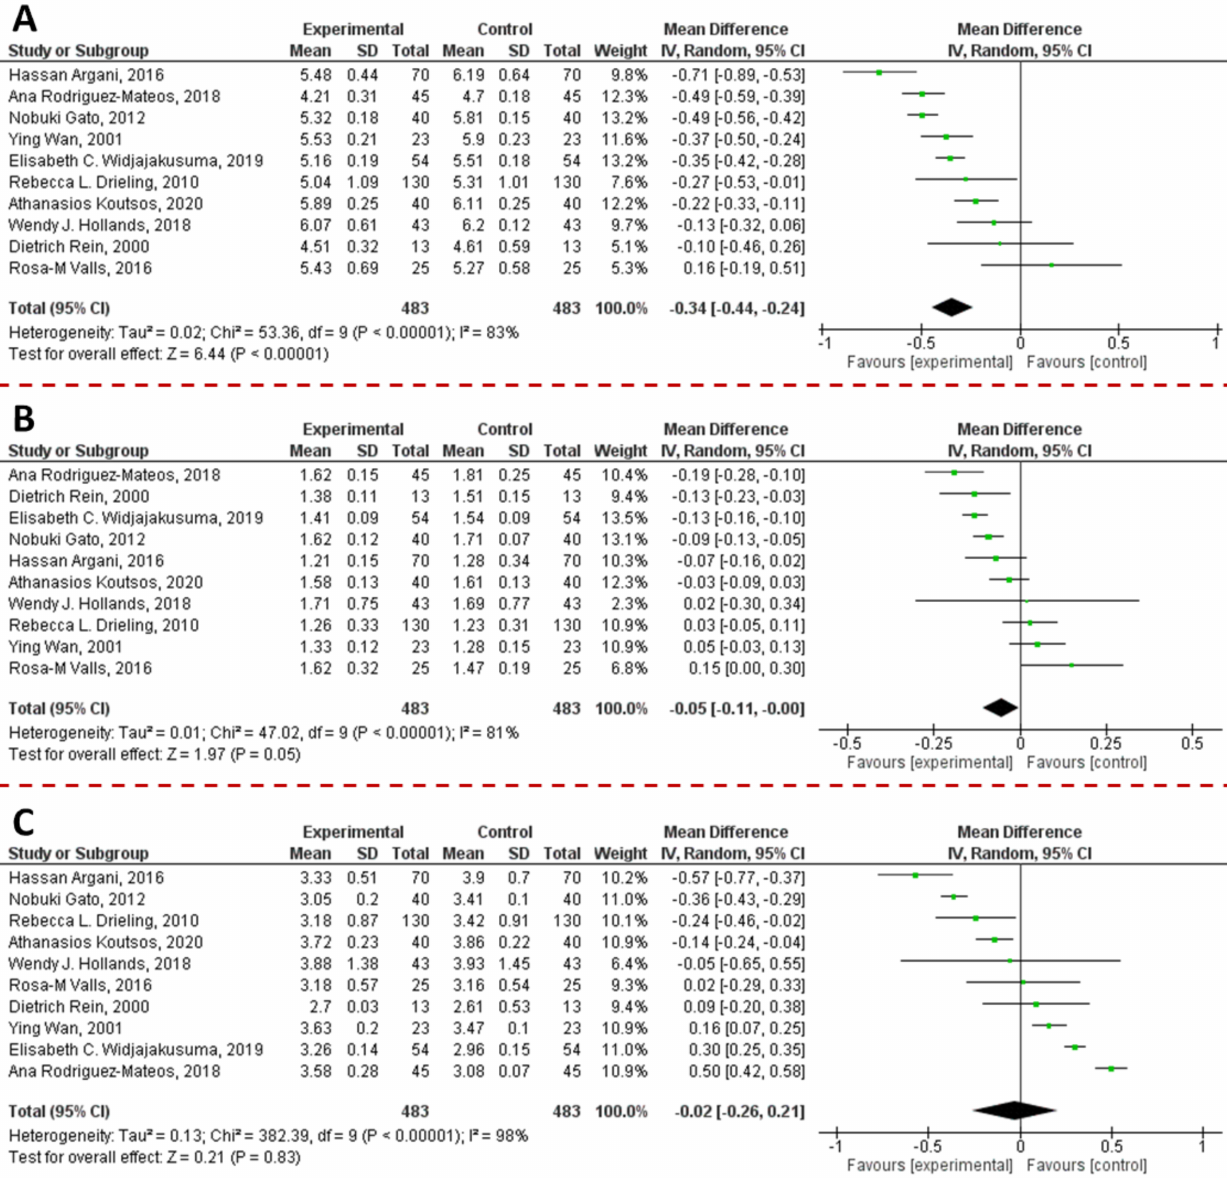
Figure 16. Forest plot representation of the effects derived from the supplementation of PACs on total cholesterol ( A ), HDL ( B ), and LDL ( C ) levels. Data were extrapolated from [187,267–275], and plotted according to the mean difference. Each horizontal line of the plot represents an individual study, reporting the punctual result plotted as green box. The weight of each study is represented by the size of the green box. The horizontal line indicates the lower and upper limit of the 95% Confidence Interval (CI) of the effect observed for each study. The vertical line represents the no-effect. For each study, if the horizontal line crosses the vertical one, a statistically significant difference between Experimental and Control group is not observed. The black diamond at the bottom of the forest plot represents the average effect size combining together the results of all the selected studies. The horizontal points of the diamond are the limits of the 95% CI of the average value. The figure was generated by Review Manager Software, version